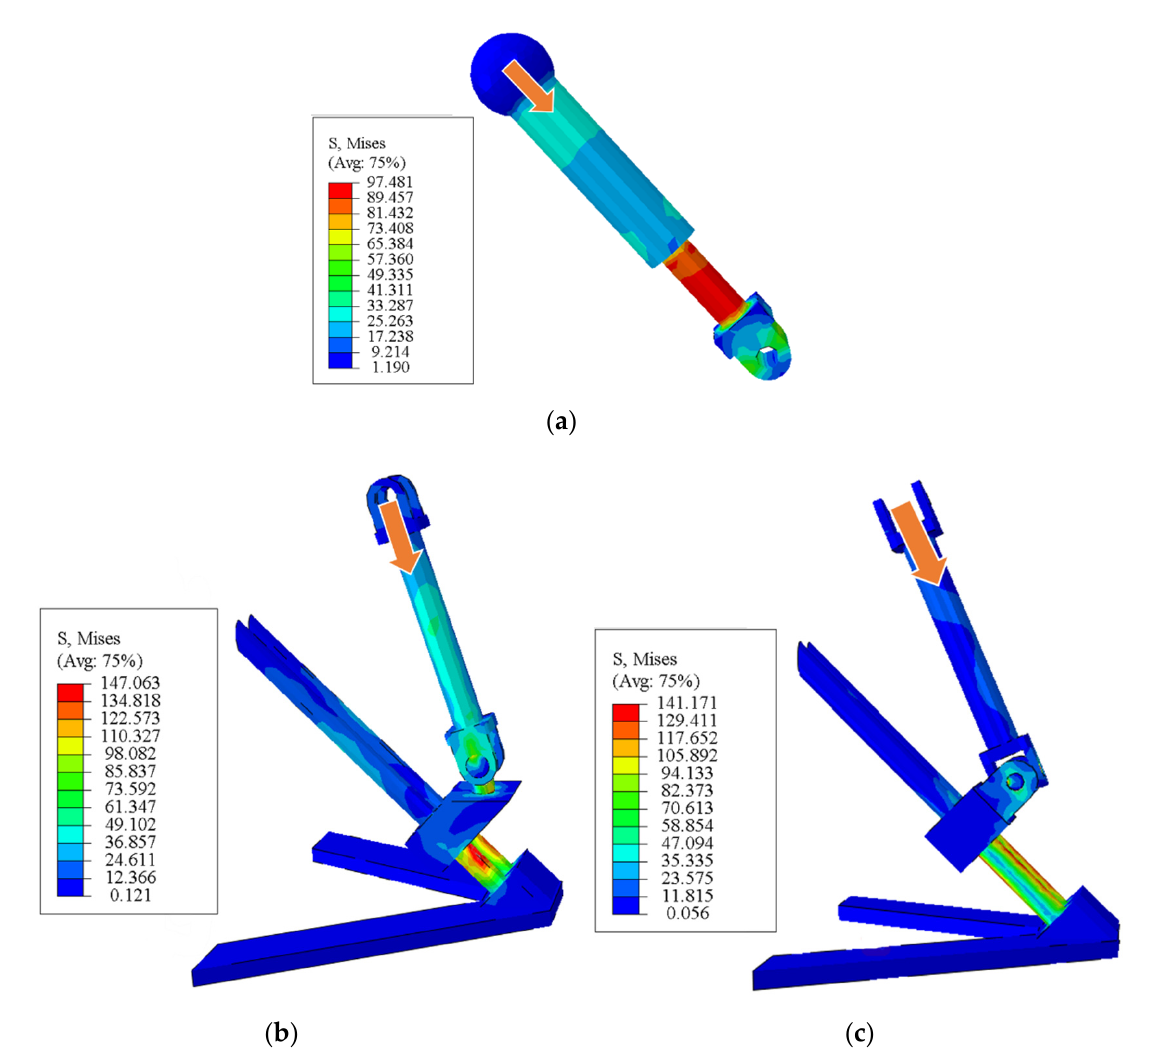
Figure 14. Stress distribution of branch chain. ( a ) Stress distribution of branch chain RPS; ( b ) stress distribution of PUU branch chain-1; ( c ) stress distribution of PUU branch chain-2.